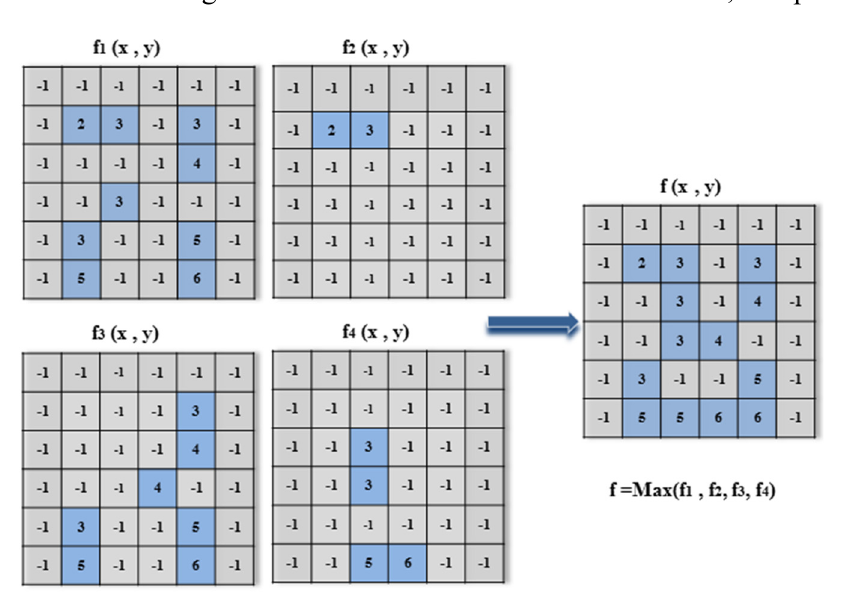
Figure 8. Illustration of obtaining the final microstructure image f